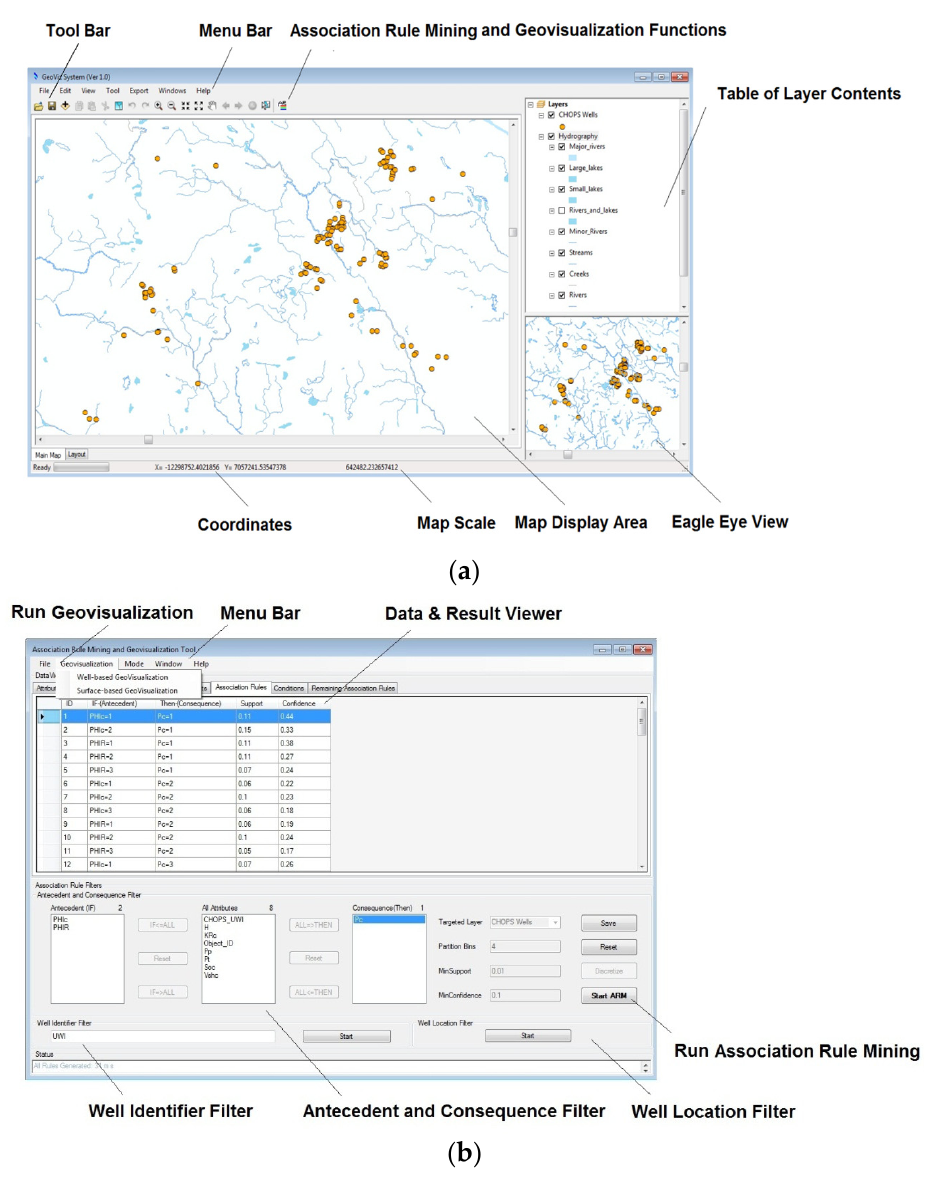
Figure 4. The main GUI of the ARM-GEOVIZ prototype. ( a ) Main GUIs of ARM-GEOVIZ system prototype; ( b ) User interface of the association rule mining.